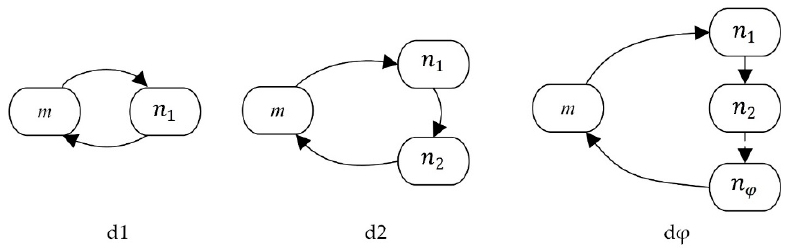
Figure 3. Different structures of the trip chain. m denotes the origin zone and n represents the des ‐ tination